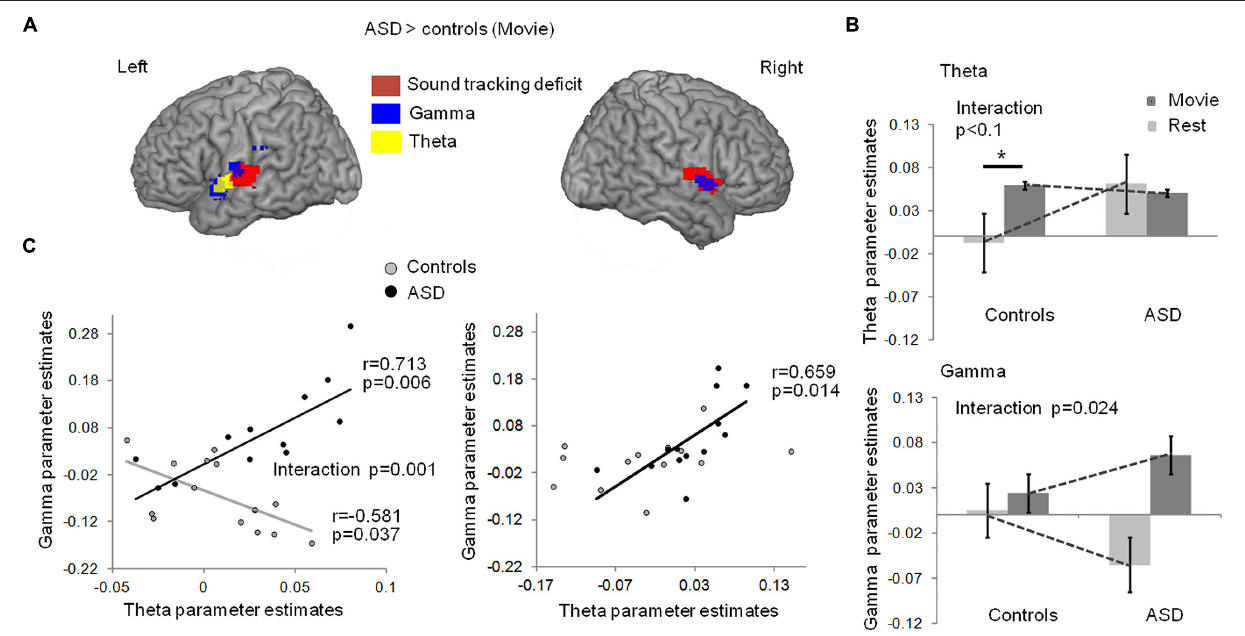
FIGURE 2 | (A) Comparison of EEG-BOLD coupling between groups with and without autism, in theta and low-gamma bands, during movie viewing. Subjects with autism had enhanced theta-BOLD (blue, whole brain p < 0.01 uncorrected, − 48, − 1, − 5 MNI coordinates; left Heschl’s gyrus, p = 0.034 FWE) and gamma-BOLD (green, left panel, p < 0.01, − 54, − 7, 10 MNI coordinates; left Heschl’s gyrus p = 0.007 FWE) coupling in the left superior temporal lobe relative to controls; subjects with ASD had enhanced gamma-BOLD coupling (green, right panel, p < 0.05, 51, − 1, 1 MNI coordinates) in the right temporal lobe relative to controls. (B) EEG-BOLD coupling at rest and during movie viewing in each group, within the theta (up panel) and gamma (bottom panel) frequency bands. The regions were